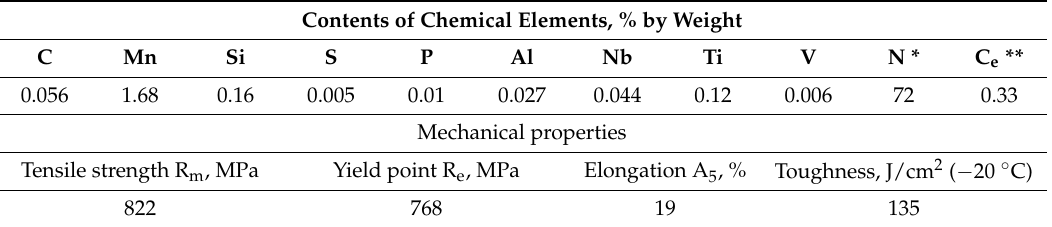
Table 1. Chemical composition of steel S700MC 10 mm thick